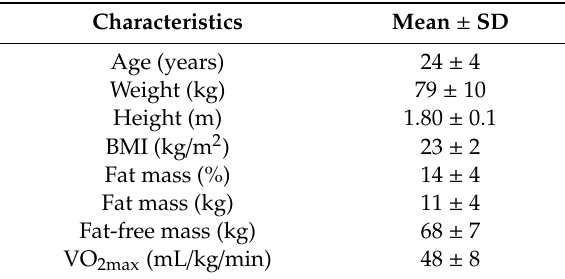
Table 1. Characteristics of